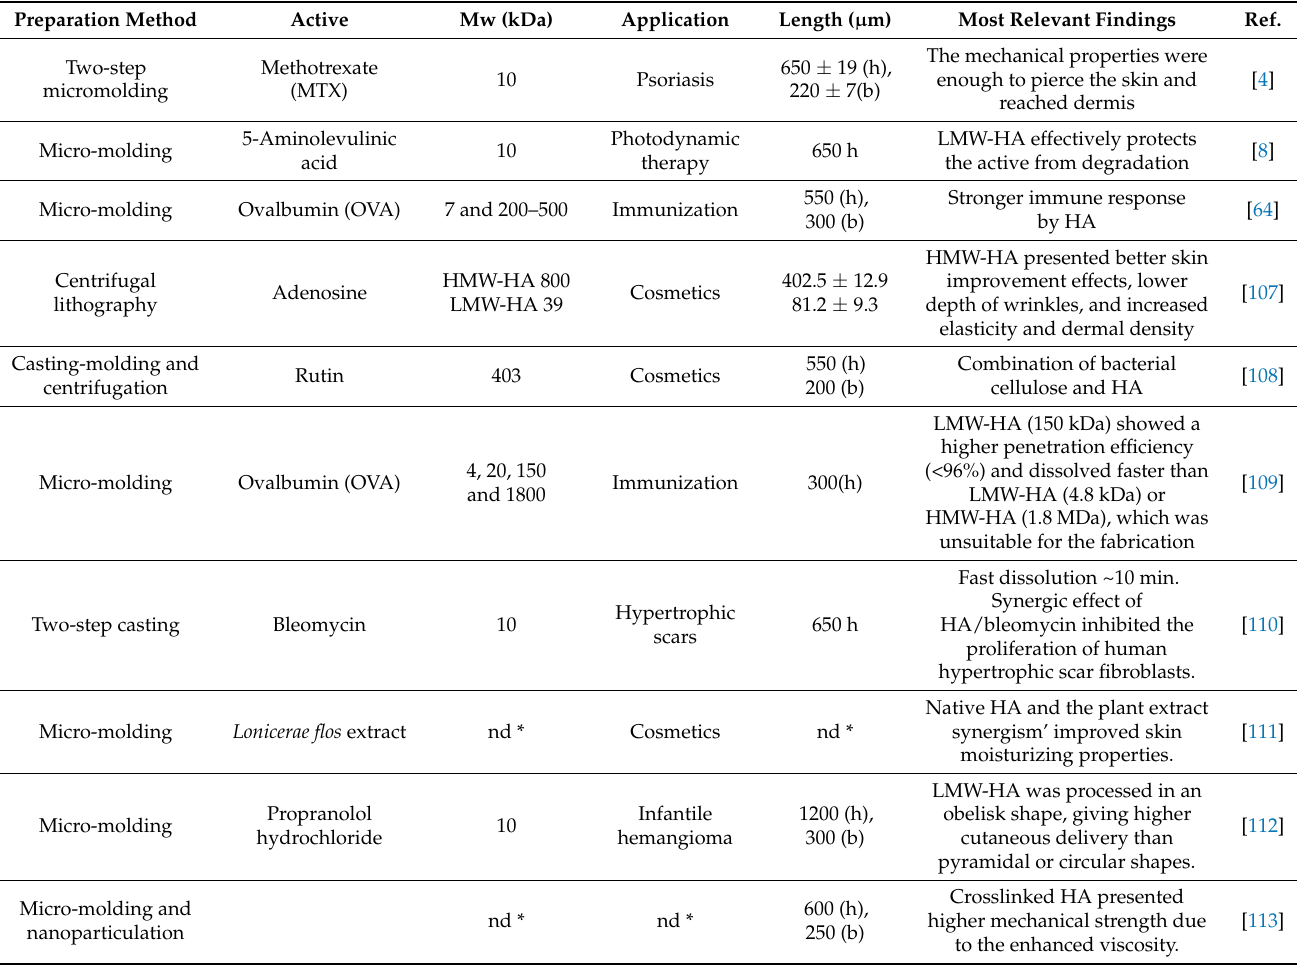
Table 4. Recent advances in dissolvable MNs of HA and its derivatives include processing, needle length, and significant outcomes (* nd means non-described in the corresponding manuscript, h stands for height, and b means